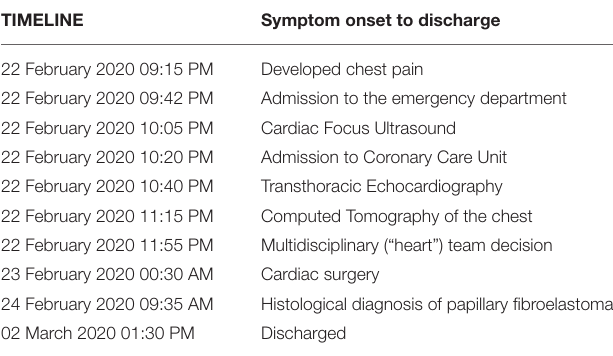
TABLE 1 | Timeline from symptoms onset to